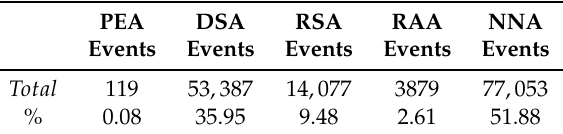
Table 9. Event categories numerical